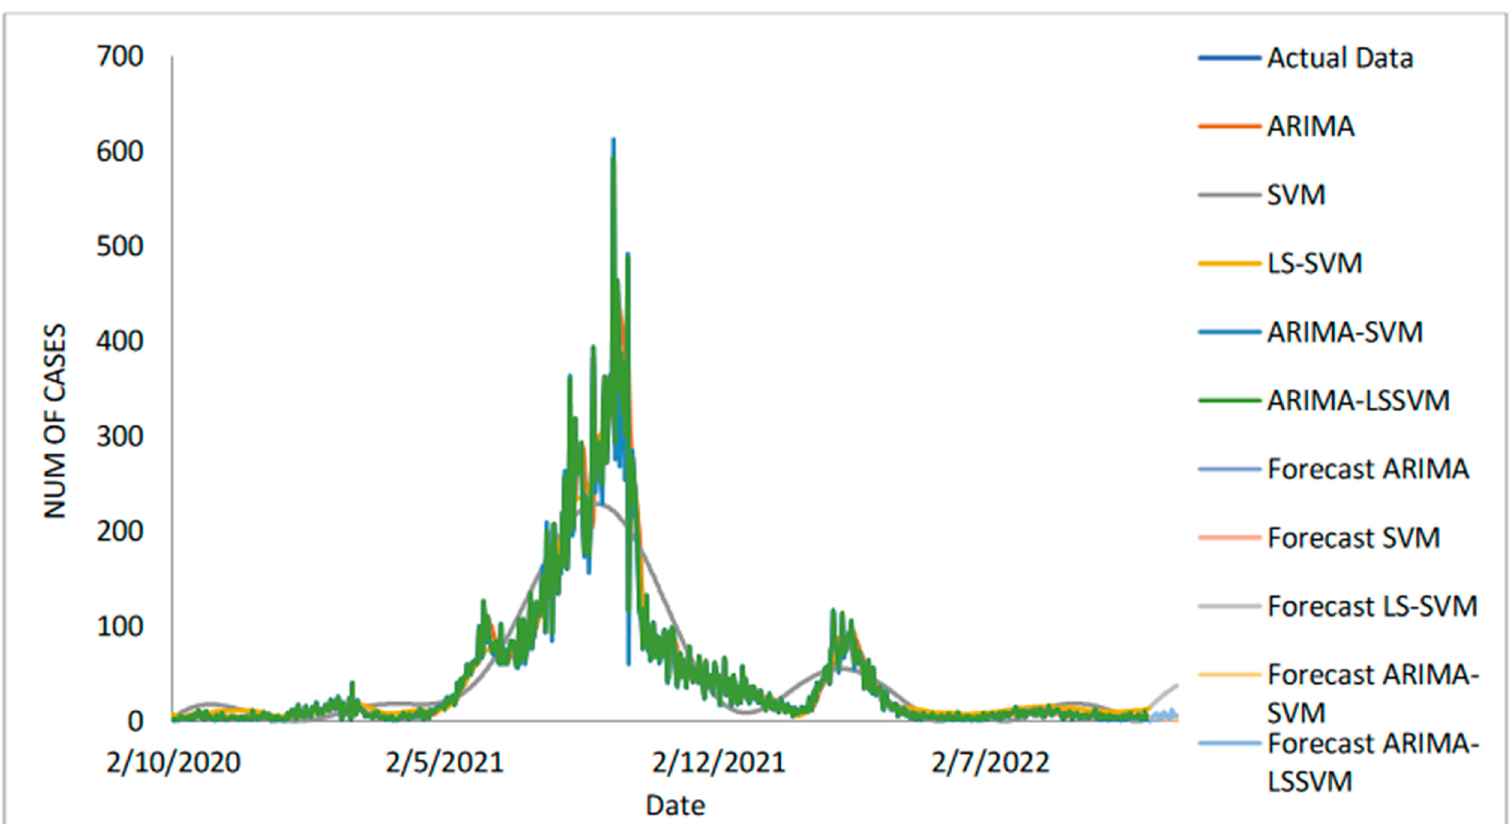
Figure 9. Actual and three-weeks-ahead forecasted values of ARIMA, SVM, LSSVM, ARIMA–SVM and ARIMA–LSSVM models for daily new deaths COVID-19 cases of the 80% training and 20% testing set.